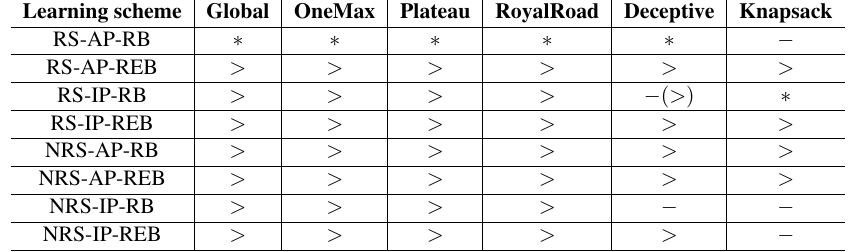
Algorithm portfolio based scheme for dynamic optimization problems Table 5. Results returned by the Holm’s and Finner’s post-hoc tests at a significance level of α = 0 . 05 when the best learning scheme globally (over all problems) and on each specific problem is compared against the others. The symbol ‘*’ indicates the learning scheme considered as control method (the method with the best mean ranking); ‘ > ’ means that the control method improves significantly the corresponding learning scheme; and ‘-’ indicates no significant differences between the two learning schemes. In case both tests do not provide the same result (e.g., Holm’s test does not rejects the hull hypothesis and Finner’s does), Finner’s post-hoc test result is displayed within parenthesis. Learning scheme Global OneMax Plateau RoyalRoad Deceptive